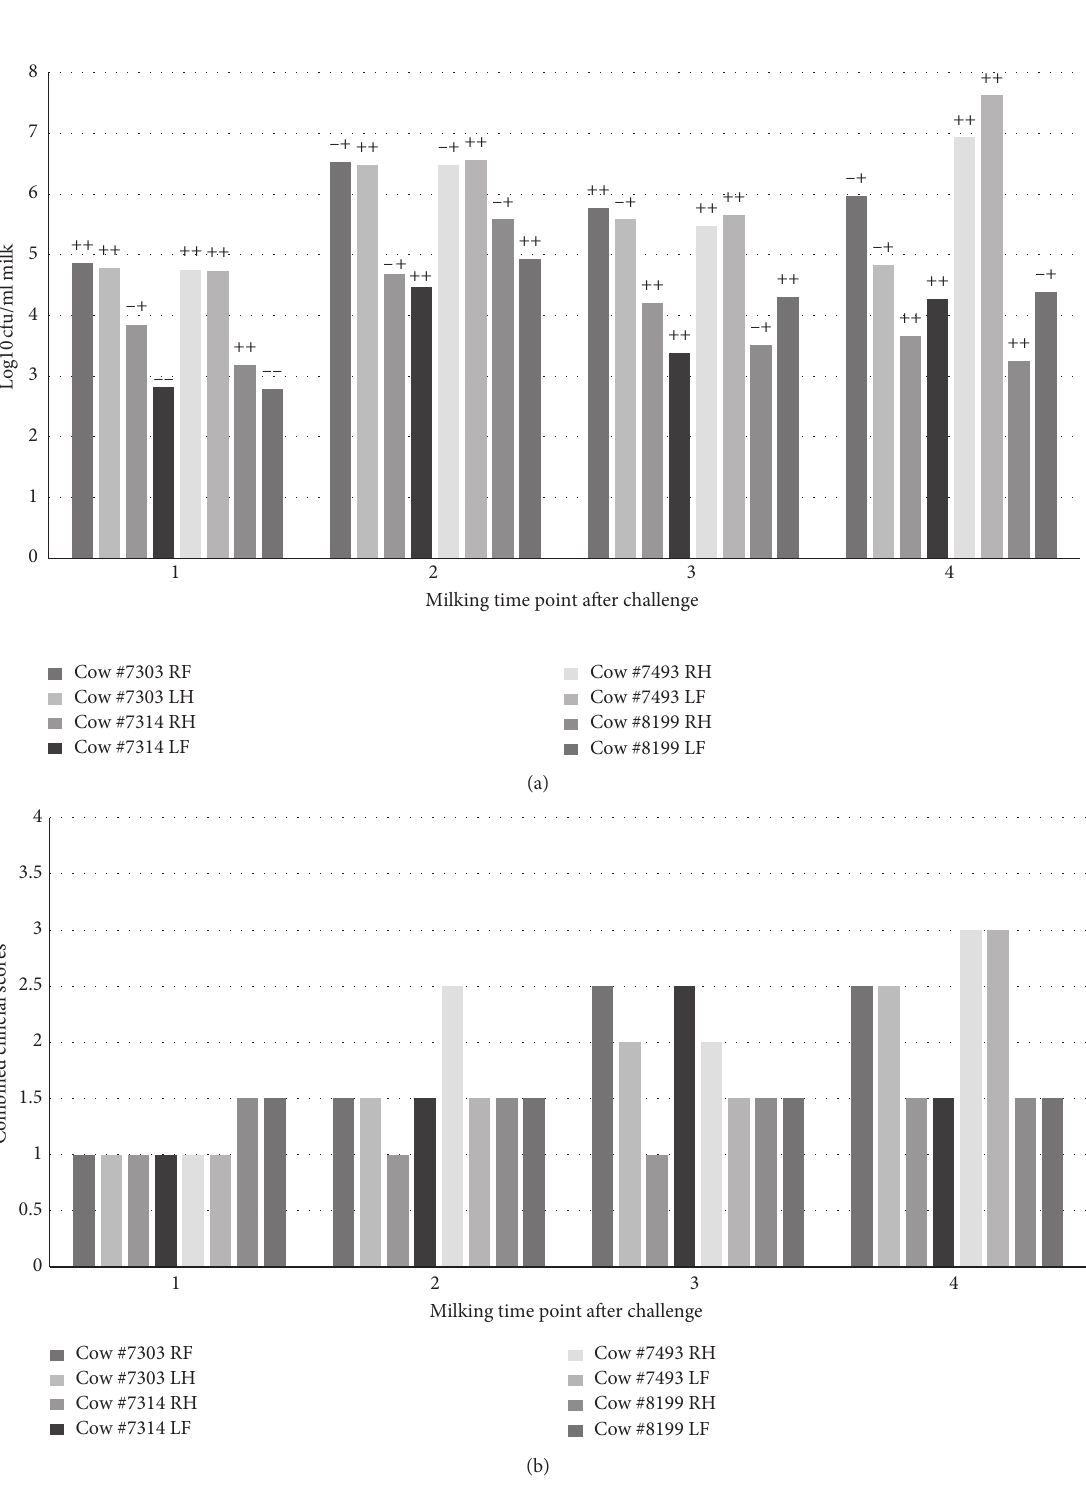
Figure 4: Detection of S. uberis from experimentally challenged cows in comparison to bacterial concentration and clinical score. (a) Comparison of bacterial cell counts obtained from direct plating of infected milk samples and detection of S. uberis from the same samples by multiplex PCR. (--) negative for sub0888 and sub1154, ( − +) positive for sub1154 only, (++) positive for sub0888 and sub1154, with bacterial detection by PCR confirmed by 24hrs after infection in all samples. (b) Clinical scores for milk quality and composition as per previous published guidelines (Field